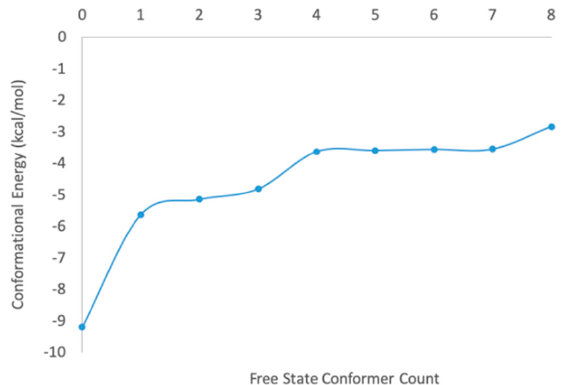
Figure 4. Energy distribution of the top 9 sampled ligand conformations ranked based on the conformational energy in the solution phase.